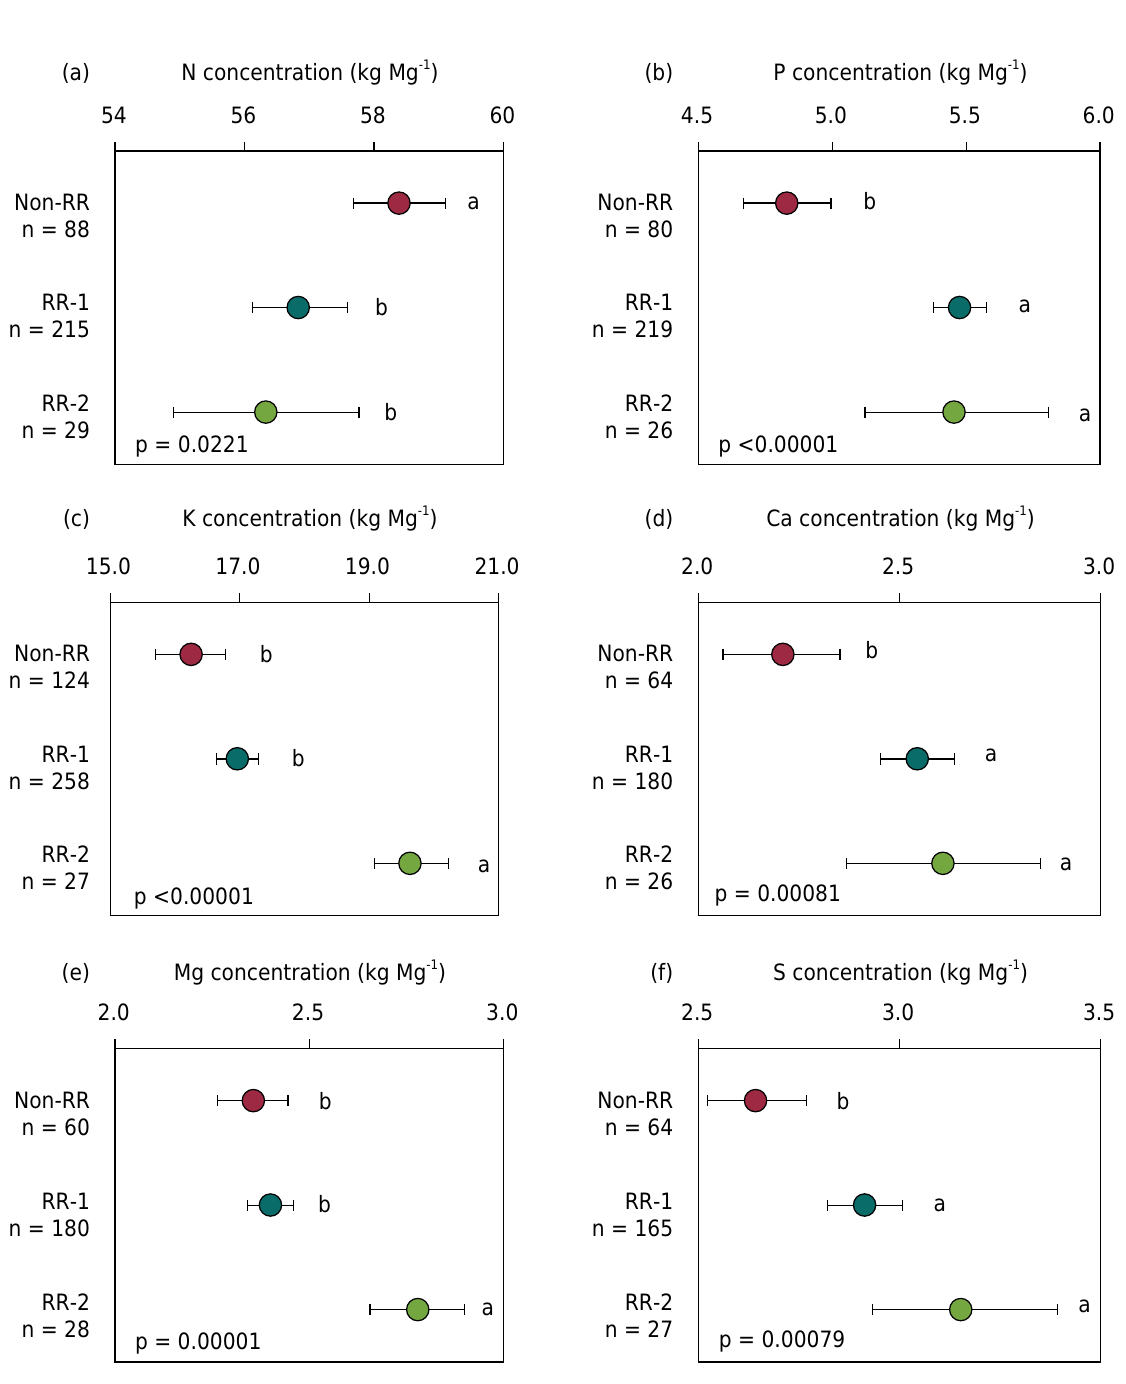
Figure 2. Concentration of N (a), P (b), K (c), Ca (d), Mg (e), and S (f) in soybean seeds of each genetic material group from studies published between 2005 and 2019. Non-RR: conventional material; RR-1: Roundup Ready; RR-2: Intact RR-2. Means followed by the same lowercase letter do not differ statistically by the Kruskal-Wallis H -test (p<0.05). n = number of observations for each genetic material group. The circles indicate the mean values, and the whiskers indicate the 95 % confidence interval calculated with 5,000 samples generated using bootstrap